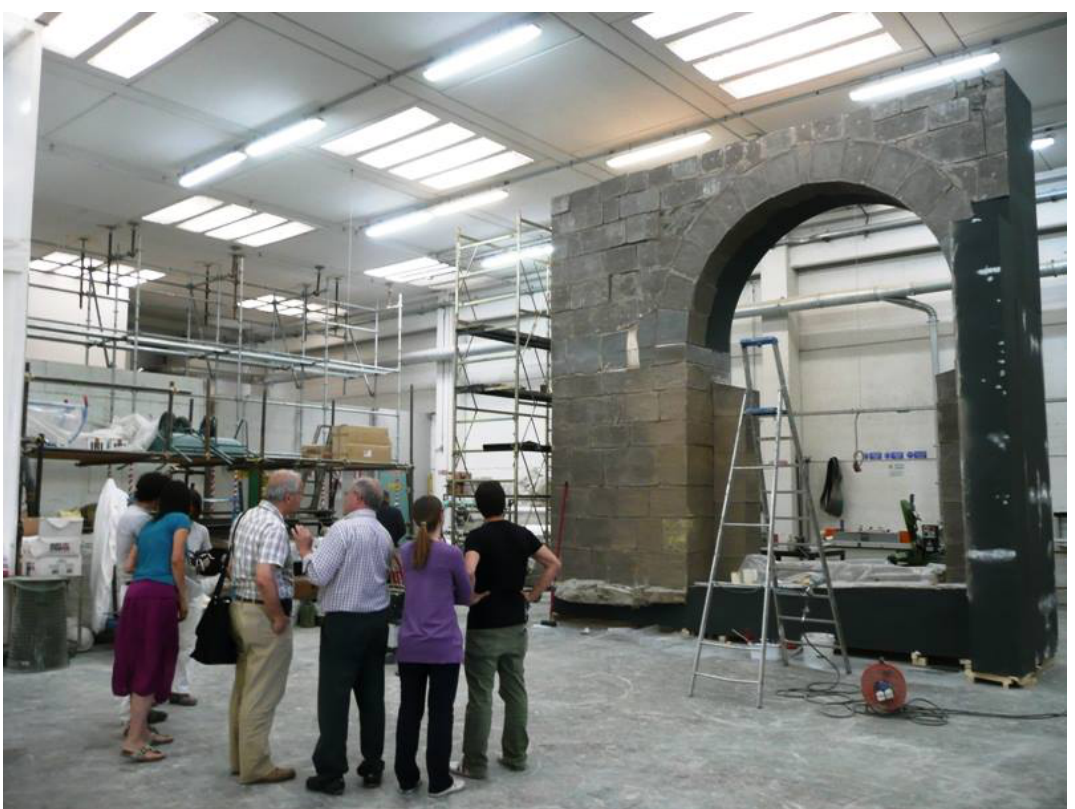
Figure 5. The full-scale 3D model of Corpo di Fabbrica 5 (CF5) built for the exhibition From Petra to Shawbak. Archeology of a